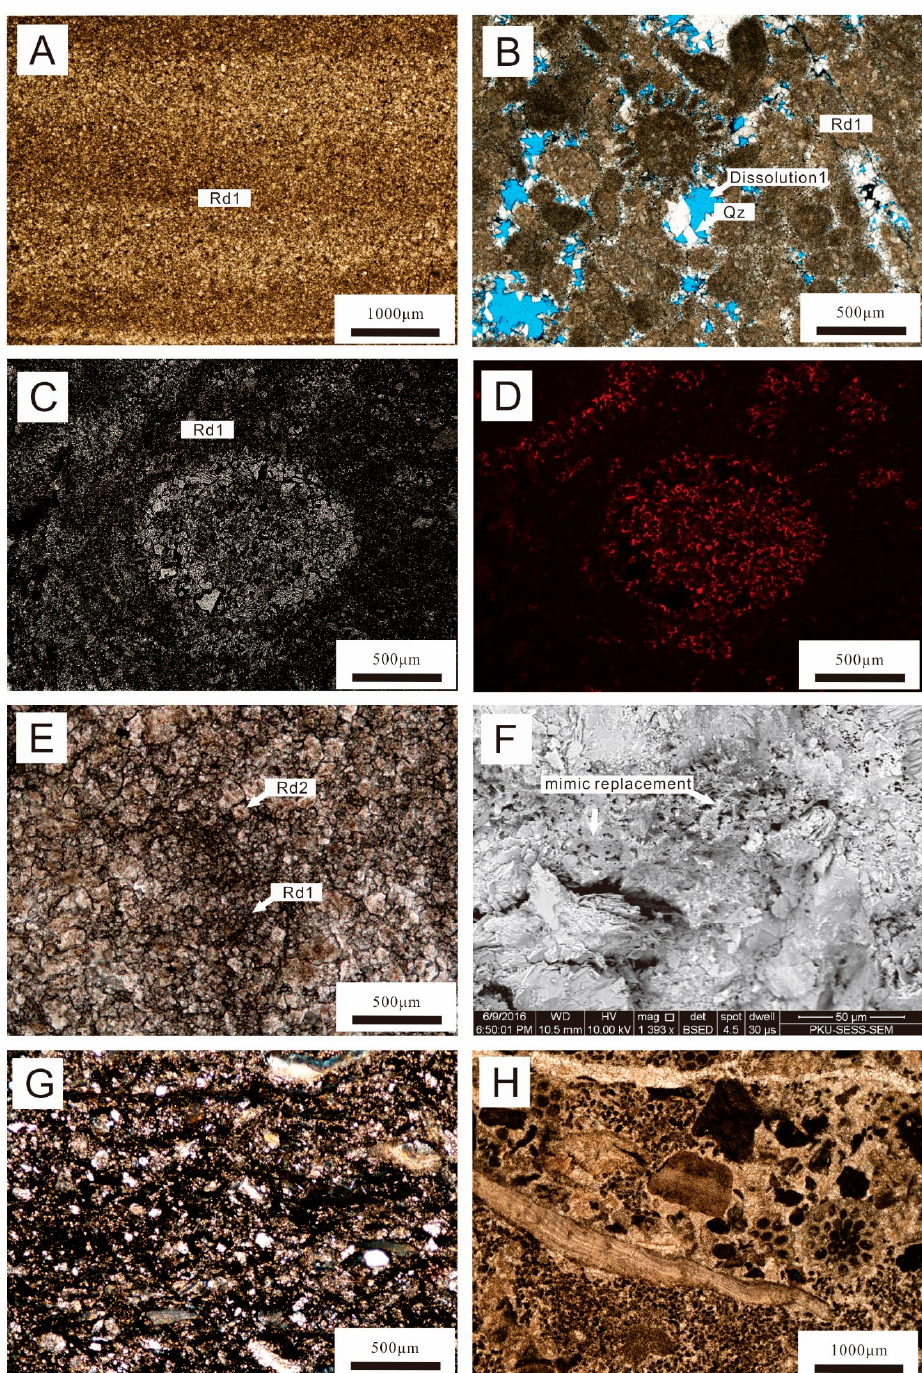
Figure 4. Rd1 dolomite. ( A ) Micritic replacive dolomite (Rd1) with laminar fabric (Xinjigu; P 2 q ); ( B ) Rd1 with residual particles mimics replacement and early-phase dissolution vugs (Dissolution1) developed between the particles and later filled with quartz cements (Qz) (Xinjigu; P 2 m ); ( C ) Rd1 with residual texture (Xinjigu; P 2 m ); ( D ) cathodoluminescence (CL) photomicrograph of ( C ) exhibiting Rd1 displaying dull luminescence but bright-red thin rims in residual texture; ( E ) euhedral to subhedral Rd2 dolomite crystals were recrystallized from Rd1 dolomite, showing different sizes and shapes (Xinjigu; P 2 q ); ( F ) photomicrograph (SEM) of residual texture (Xinjigu; P 2 m ); ( G ) photomicrograph of argillaceous limestone (Xinjigu; P 2 q ); ( H ) photomicrograph of bioclast limestone (Xinjigu; P 2 m